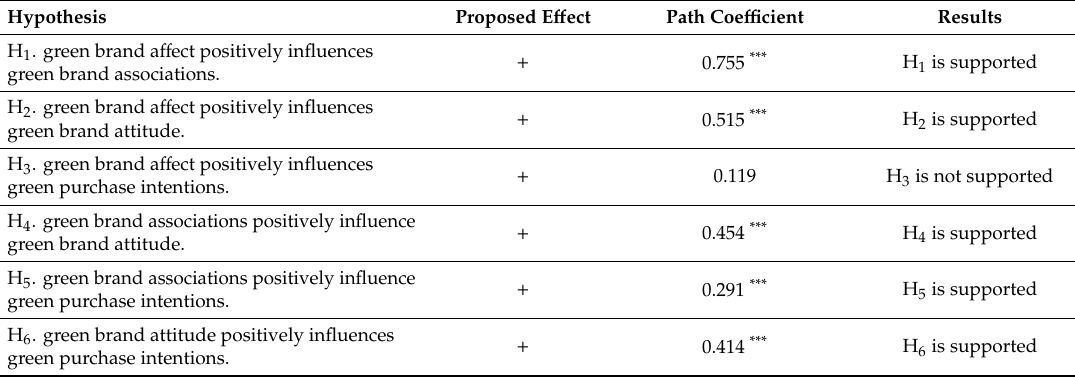
Table 5. The results of the structural model.